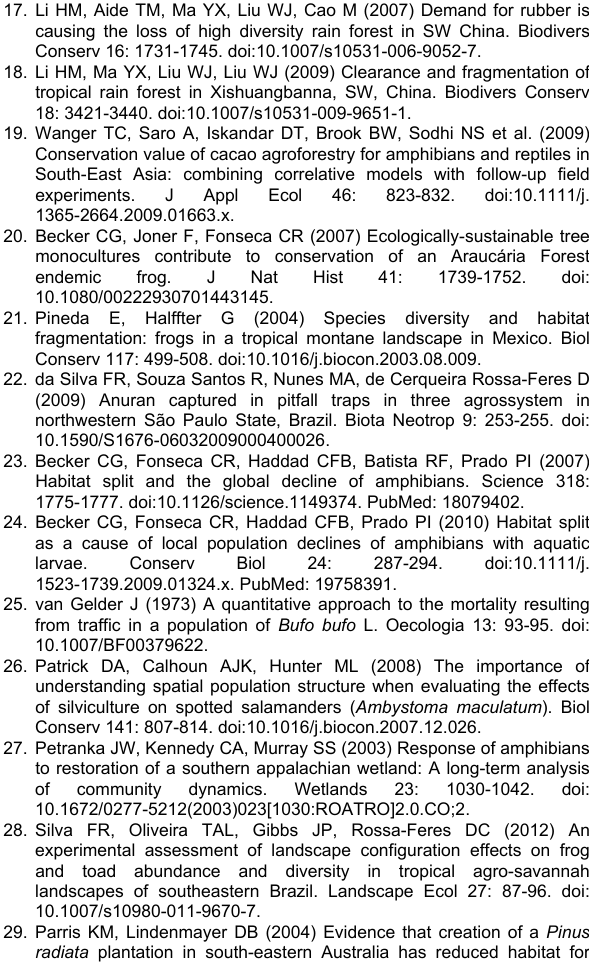
Figure S2. Individual rarefaction curves. Rarefaction curves for each habitat type generated by the rarefy function in the vegan library in R. Rarefy calculates the expected species richness for each of the three habitat types given a random subsample of a number of individuals from that community. This shows that for a random number of individuals selected from each habitat, chances are higher that they will include more species if the sample is taken from the rainforest community. Vertical lines represent one standard error of the